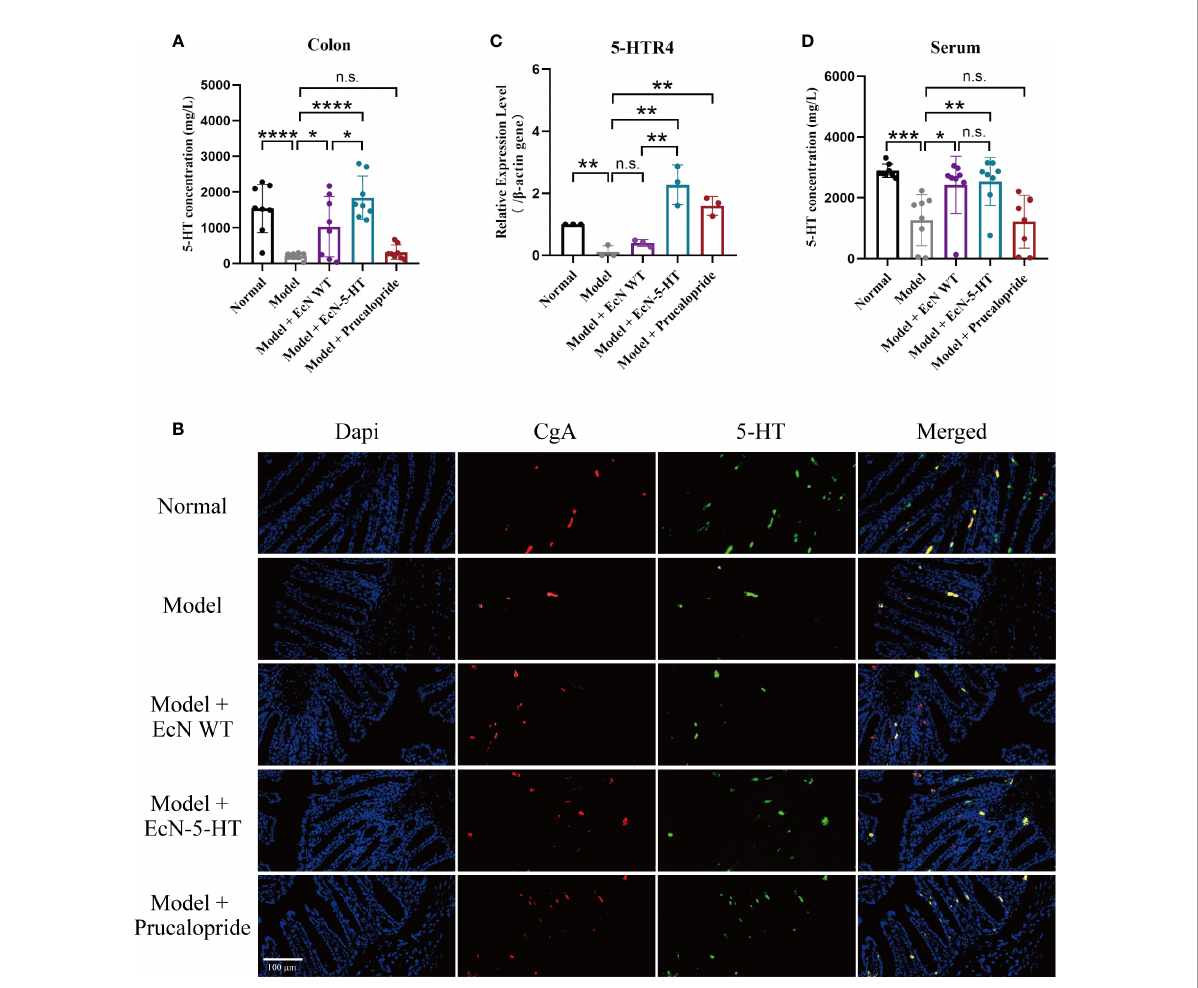
FIGURE 3 EcN-5-HT led to an increase of 5-HT concentration in constipation mice model. (A) Measurement of colon 5-HT by UPLC-MS/MS. n = 8 mice per group (B) Fluorescent microscope pictures of colon showing CgA antibody staining (red), 5-HT antibody staining (green) and cell nuclei (blue). (C) 5-HTR4 mRNA expression in colon tissue. n = 3 mice per group. (D) Measurement of serum 5-HT by LC-MS. n = 8 mice per group. Mean values ± SDs are presented, p values were calculated using unpaired t-test, *p < 0.05, **p < 0.01, ***p < 0.001 and ****p < 0.0001. n.s, not signi fi